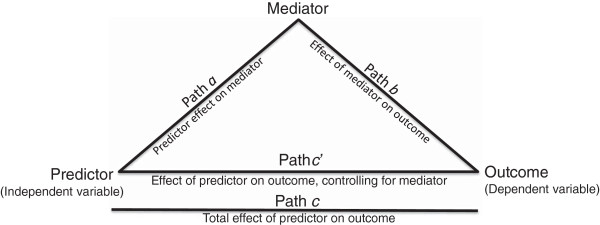
Guide for interpretation of mediation analyses.